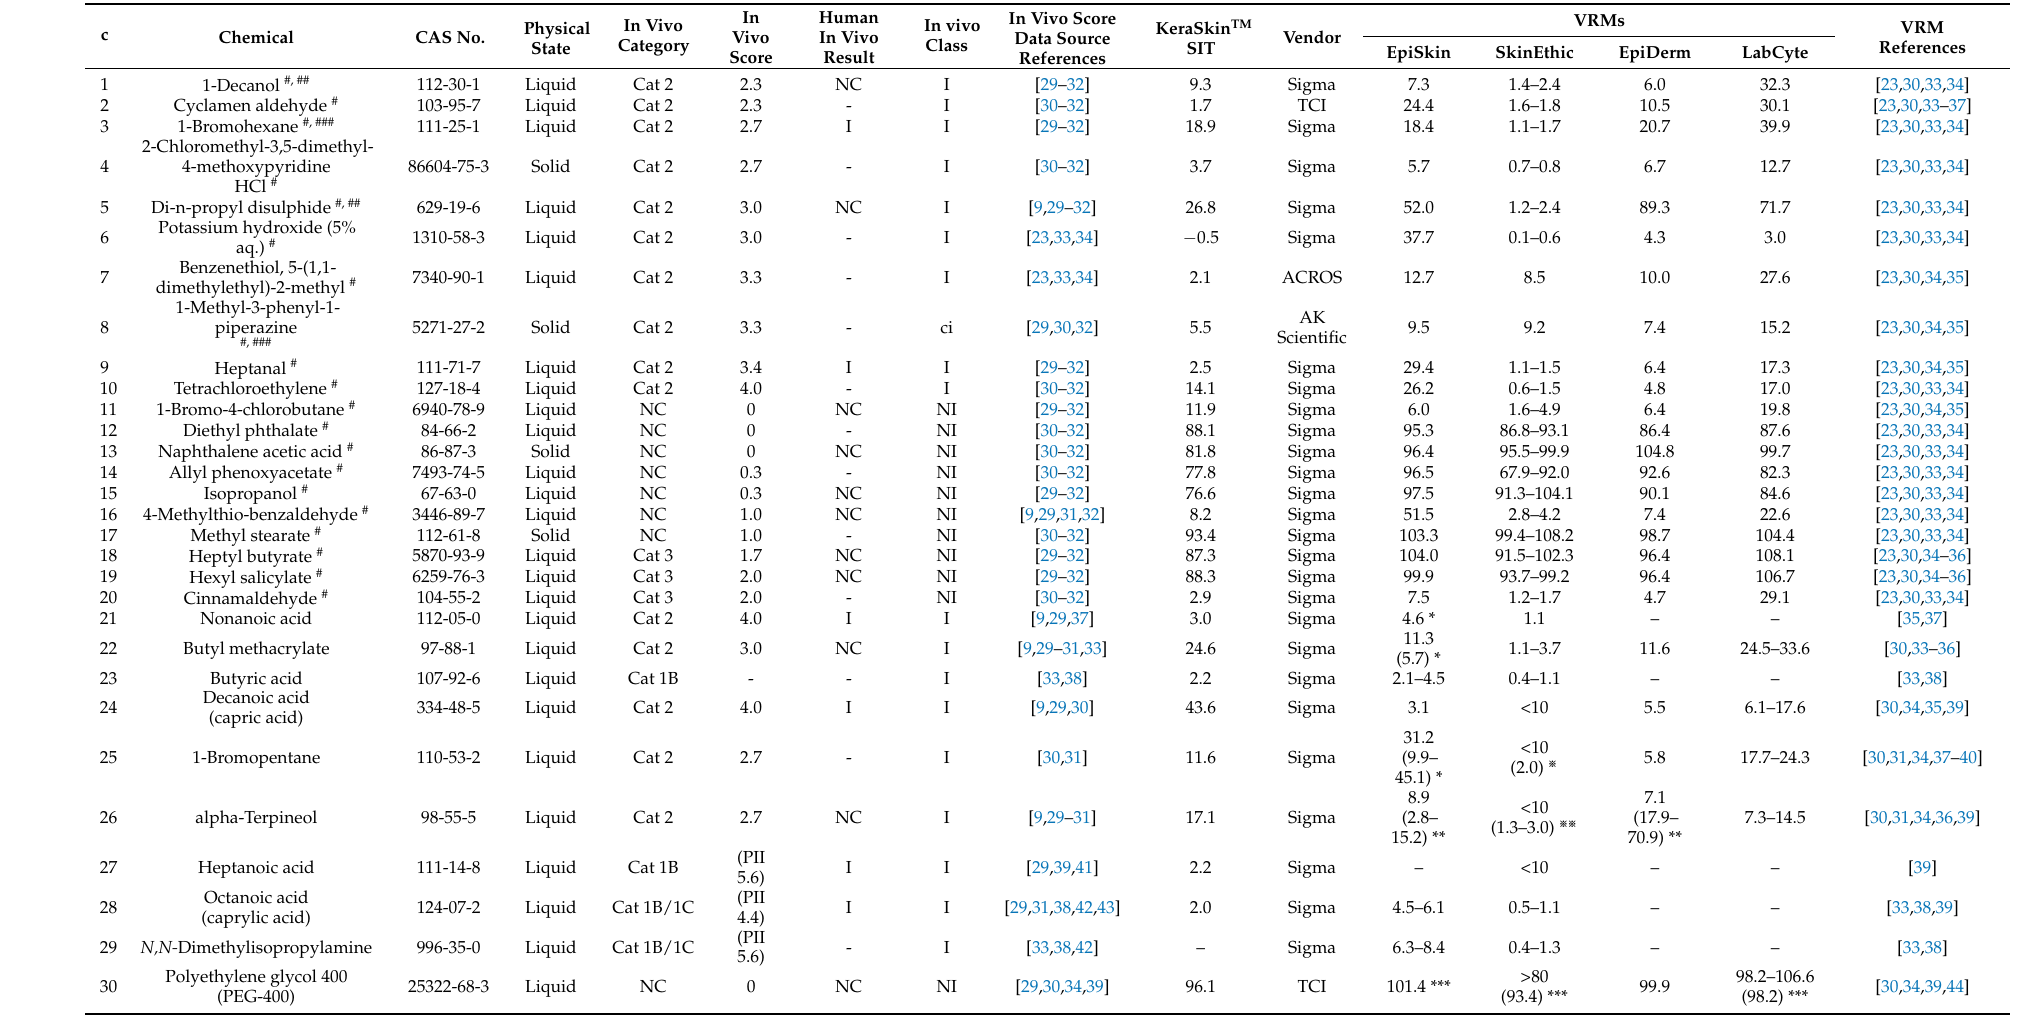
Table 2. Information of major reference chemicals among substances included in ChemSkin